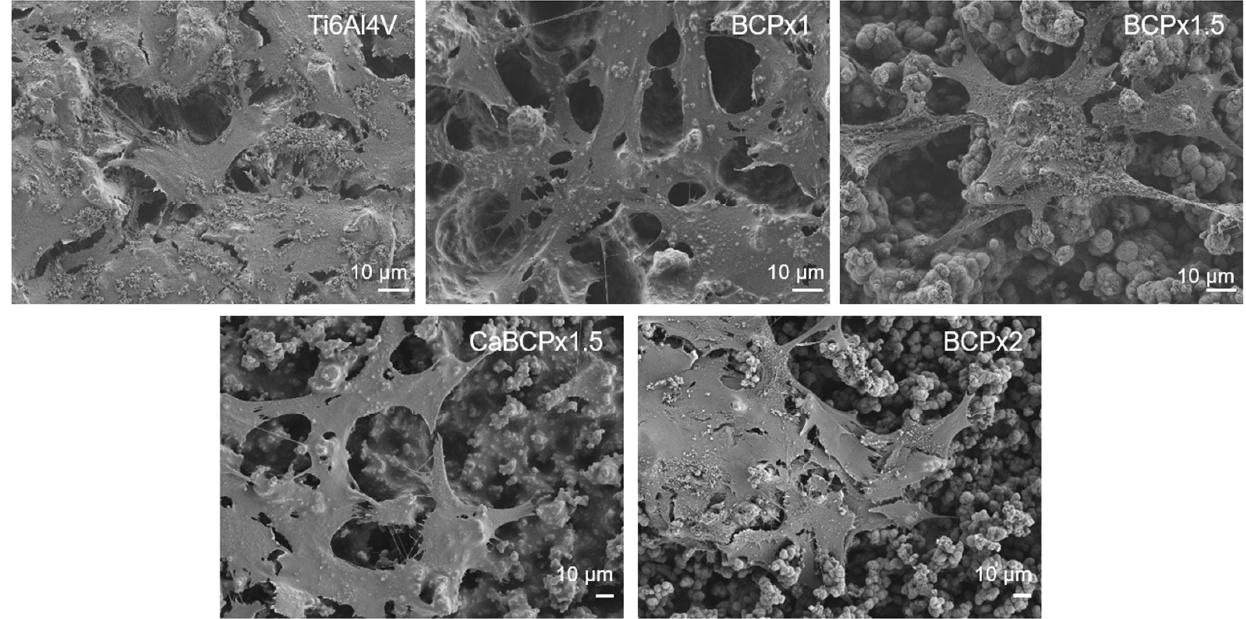
Figure 4. Cell morphology of human osteoblasts growing on coatings precipitated on chemically pre-treated Ti6Al4V substrates after exposure to BCPx1, BCPx1.5 with and without CaCl2 pre-treatment, and BCPx2 for 14 days. Images were taken 48 h after cell seeding with an SEM, scale: 10 µm. Overview images can be found in the Supplementary Materials.